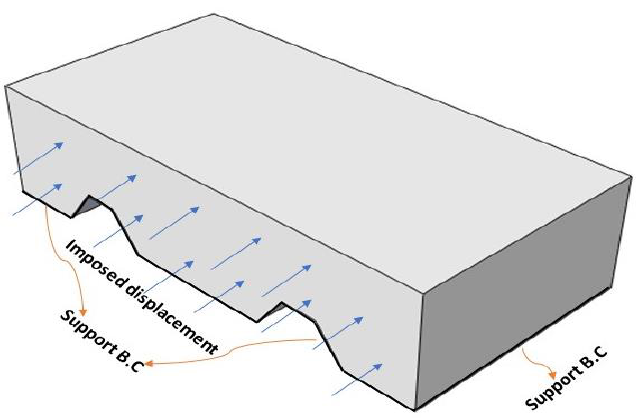
Figure 8. Geometry and boundary conditions.